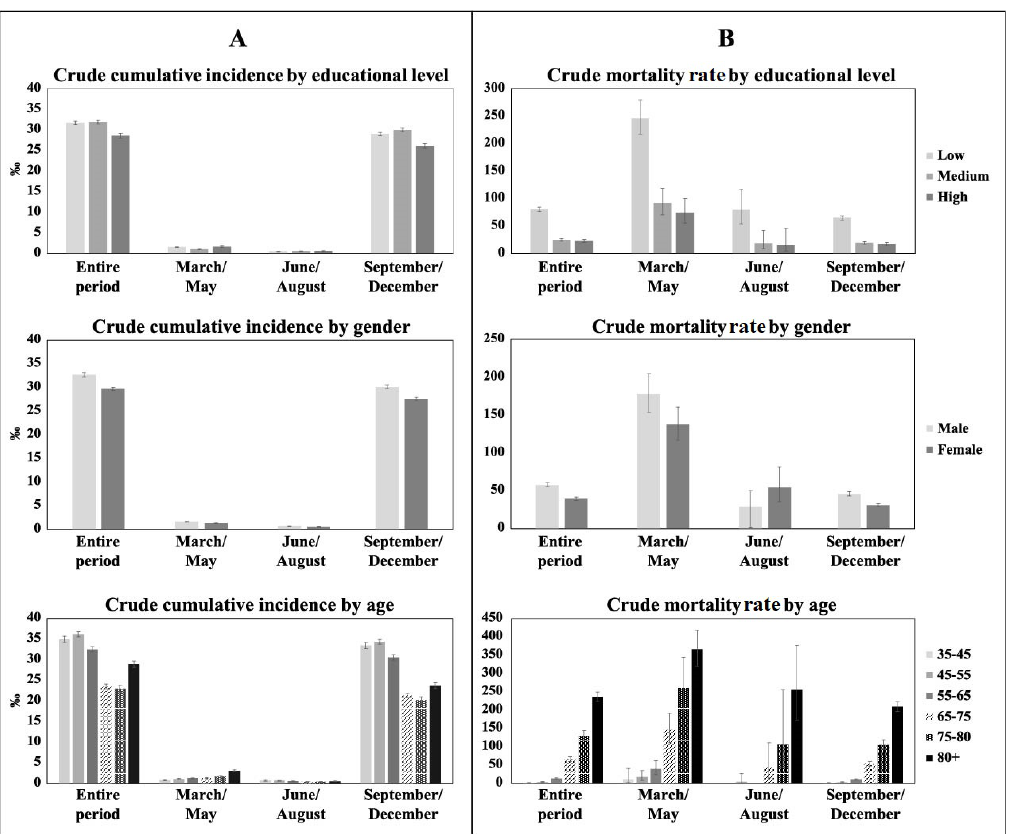
Figure 1. ( A ) Crude cumulative incidence and ( B ) crude mortality rate by educational level, sex, and age for the entire period and in the three phases of the pandemic.